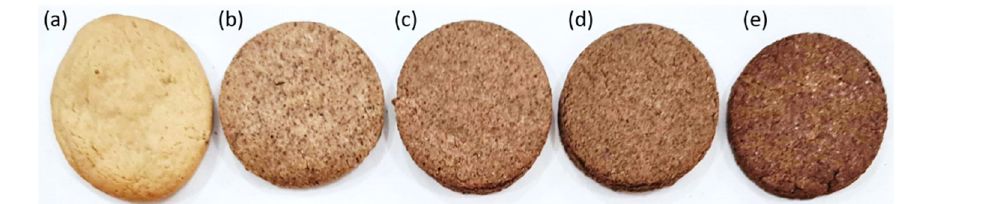
Figure 2. Coloring of the cookies obtained from the formulations with ( a ) 0%, ( b ) 10%, ( c ) 20%, ( d ) 30%, and ( e ) 40% substitution of wheat flour for CS flour.